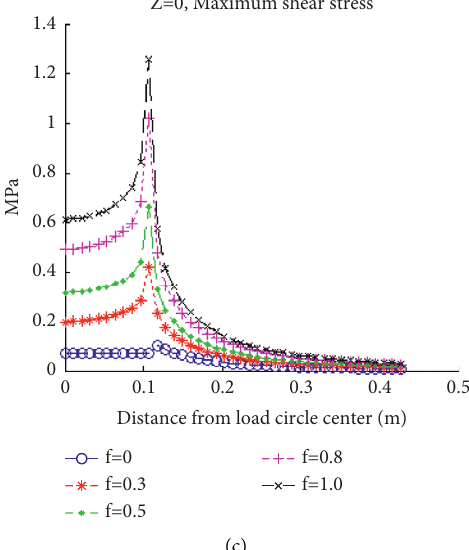
Figure 9: Calculation results of principal stress of structure in x -axis ( z � 0). (a) Calculation results of maximum principal stress of structure in x -axis ( z � 0). (b) Calculation results of third principal stress of structure in x -axis ( z � 0). (c) Calculation results of maximum shear stress of structure in x -axis ( z �